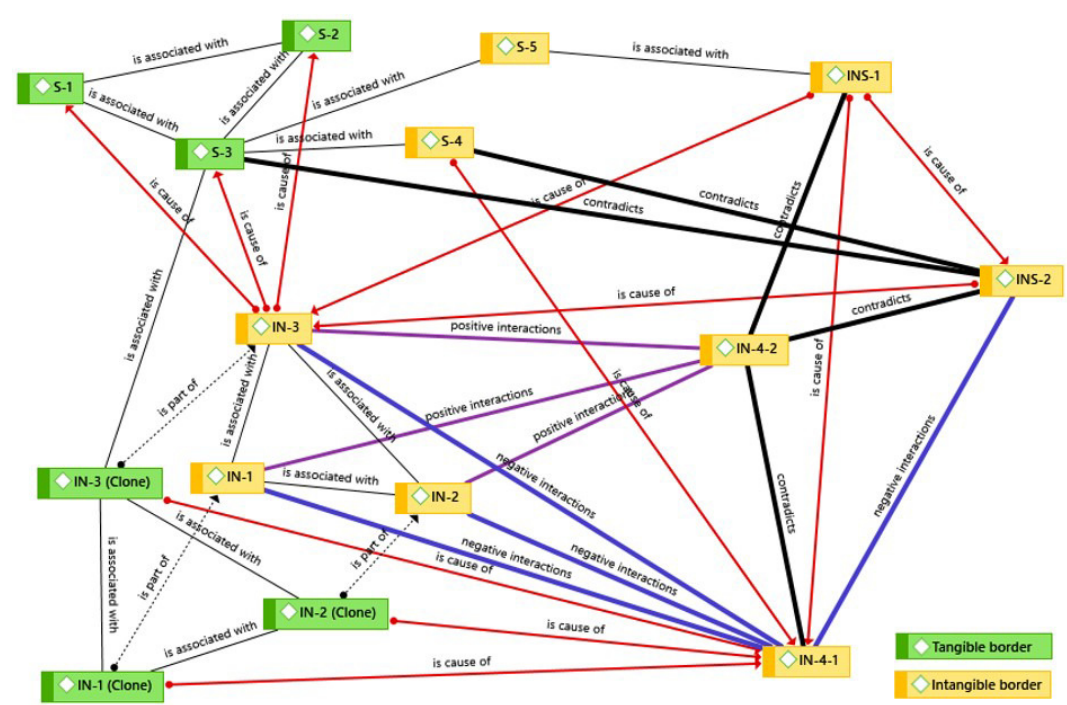
Figure 3. The relationship network between codes. by ‘S‐4’ are also changed by ‘IN‐4–1.’ In other words: ‘IN‐4–1 Port‐related values and ideas from non‐harbour people’ is particularly the perception that the port is not that far away from the industrial park. When this is recognised by the industrial park manager, he begins to expect possible collaboration opportunities between the port and the city. A later step emerges as a specific plan, connecting manufacturing industries with the cruise ship industry. This example demonstrates that a penumbral perspective is a precondition of specific development plan which changes borders and connects the port and the city